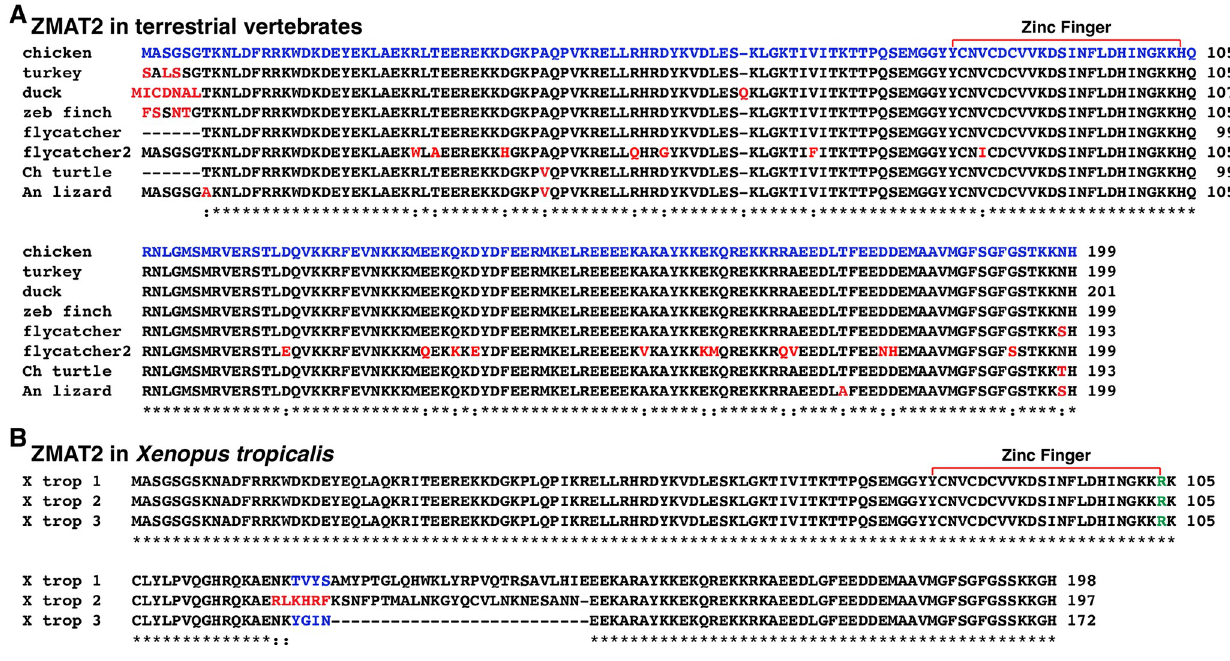
Fig 5. Terrestrial vertebrate ZMAT2 proteins. A . Alignments of amino acid sequences of ZMAT2 proteins from different terrestrial vertebrate species are shown in single letter code. Identities and differences among proteins are indicated, with identities labeled by asterisks, and differences by colons. Dashes indicating no residue have been placed to maximize alignments. Red text also depicts differences. The zinc finger region has been labeled. B . ZMAT2 in Xenopus tropicalis . The three different proteins have been aligned. Dashes have been placed to maximize alignments. Identities are labeled by asterisks, and variant amino acids are depicted by colons and are labeled red and blue. The single change with other vertebrates of histidine to arginine in the zinc finger domain has been labeled in green. See Table 4 for additional